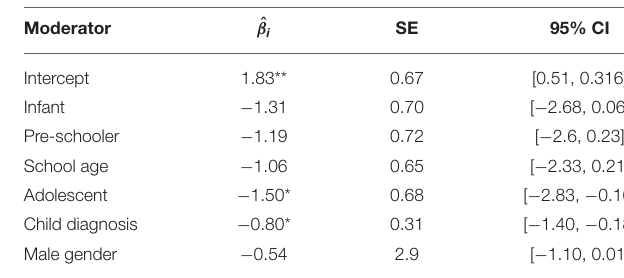
TABLE 4 | Results of meta-regression including hypothesized